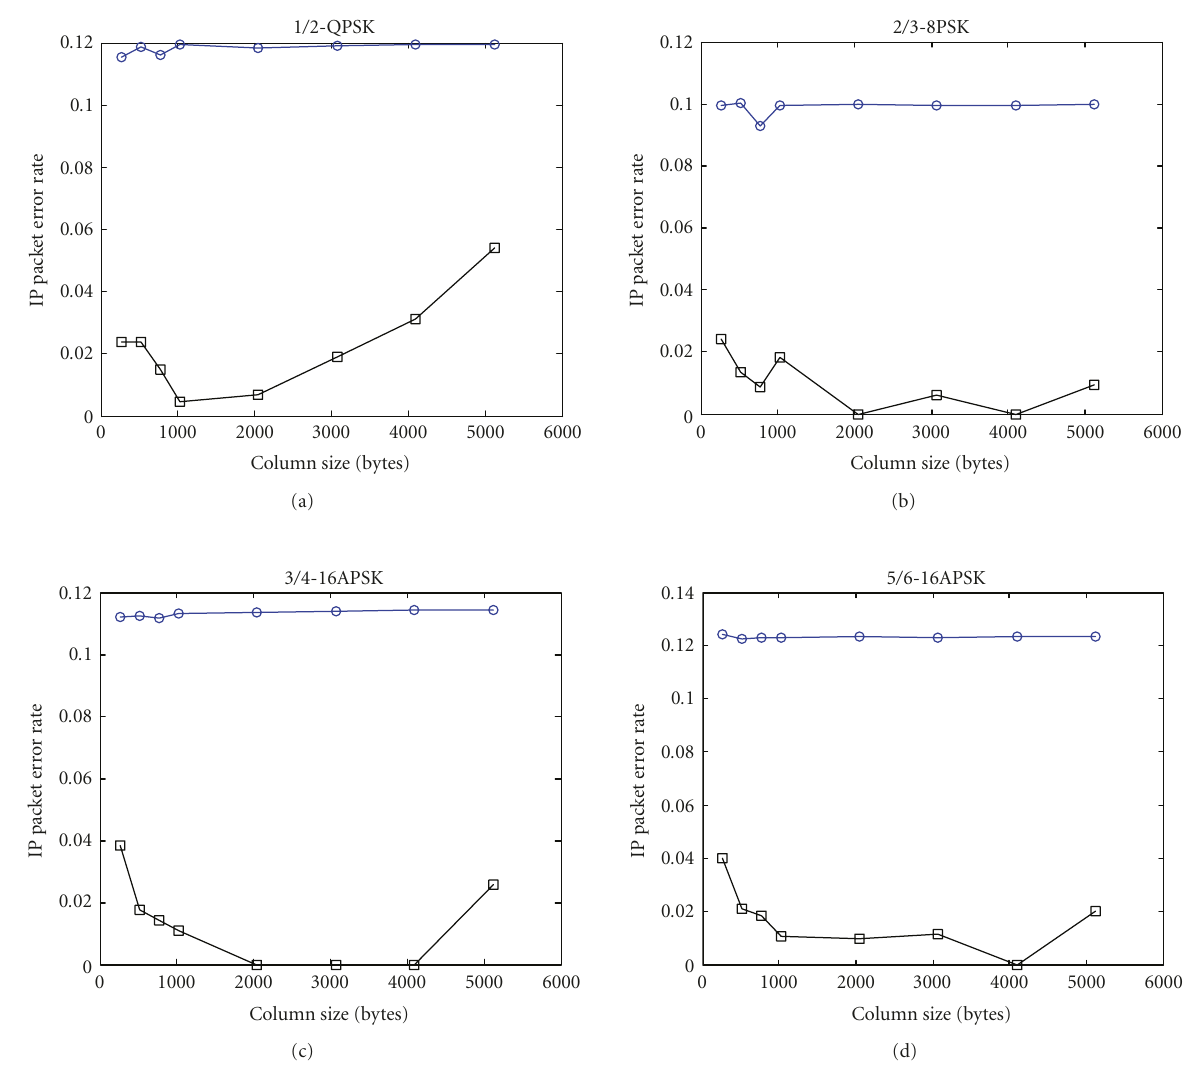
Figure 12: Comparison of the IP packet error rate for di ff erent ACM modes in a channel with BBFRAME error rate equal to 12% (circles → results without any kind of PL-FEC, squares → results with GSE-FEC).